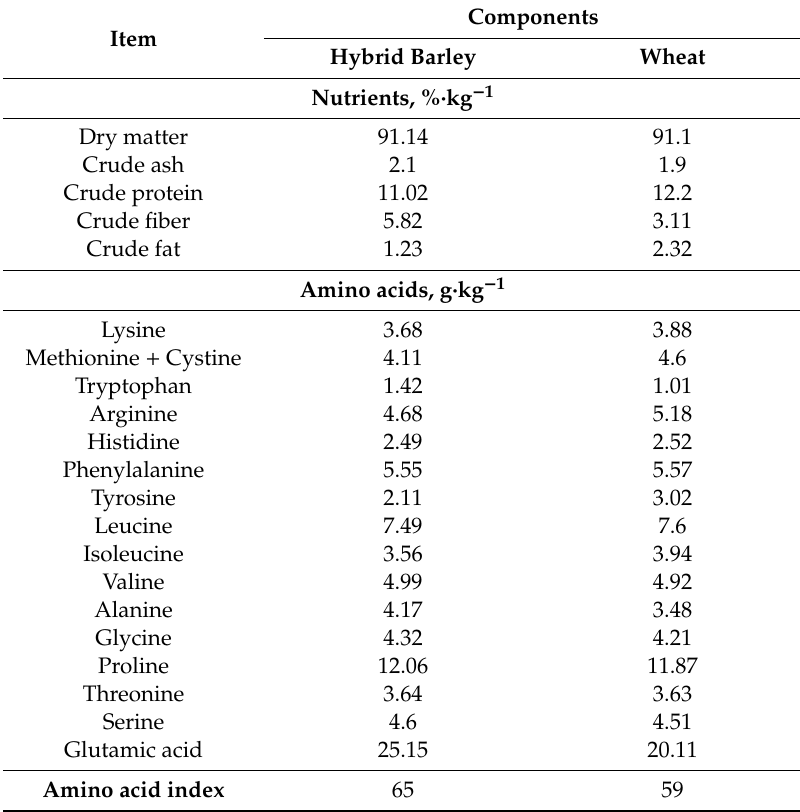
Table 2. Chemical composition and amino acid index wheat and hybrid barley. Components Item Hybrid